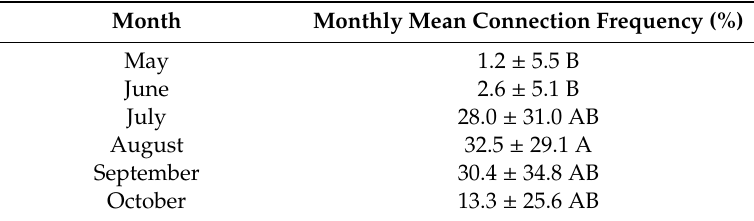
Table 2. Monthly Mean Connection Frequency among main water bodies in the study area. Means in the same column followed by the same letter are not significantly di ff erent at the 0.01 level.